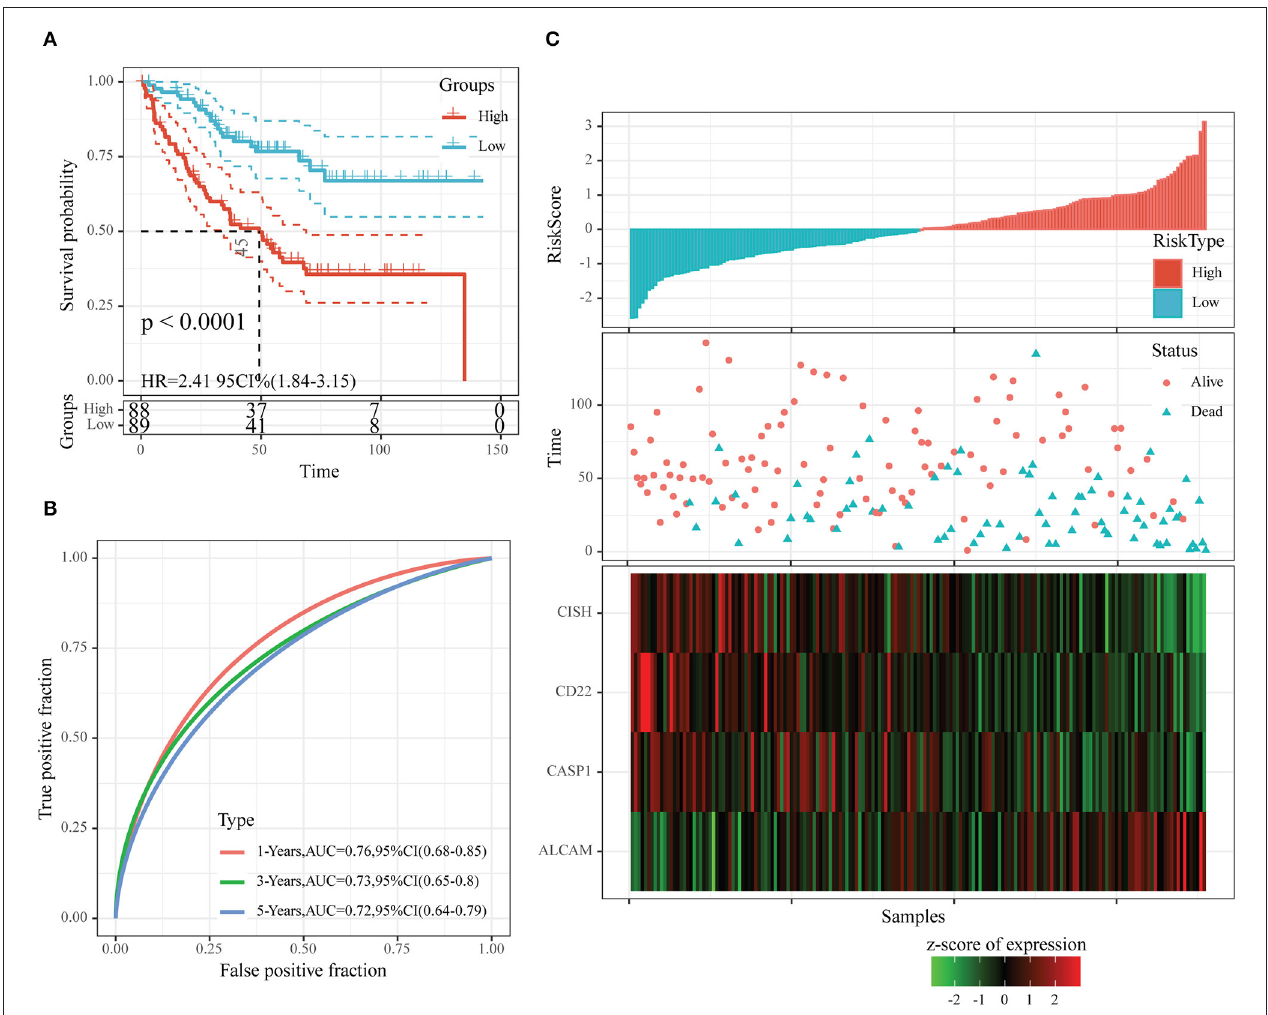
FIGURE 6 | The classification effect of the four-oxaliplatin resistance-related gene-based prognosis signature in the training set. (A) Analyzed the prognostic difference after predicted classification according to the four-gene signature in the training set. (B) Receiver operating characteristic (ROC) curves of the four-gene signature in colon cancer samples in the training set. (C) The relationship of risk score, survival time, and survival status with the expression levels of the four genes in the training